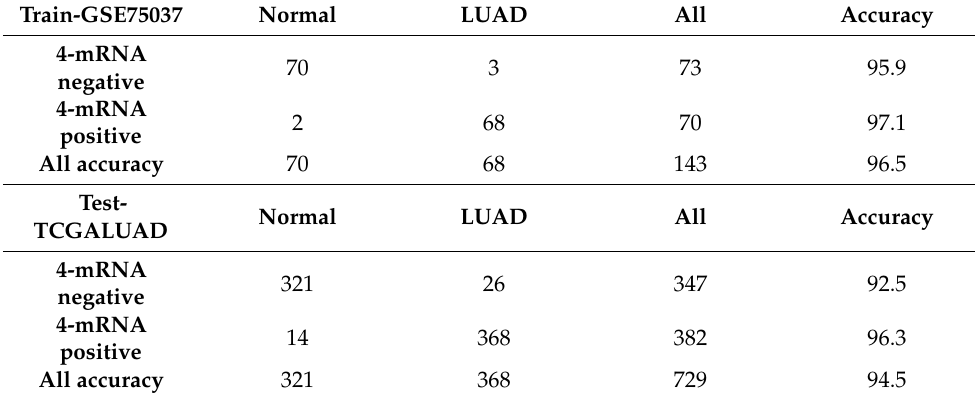
Table 2. Accuracy of early